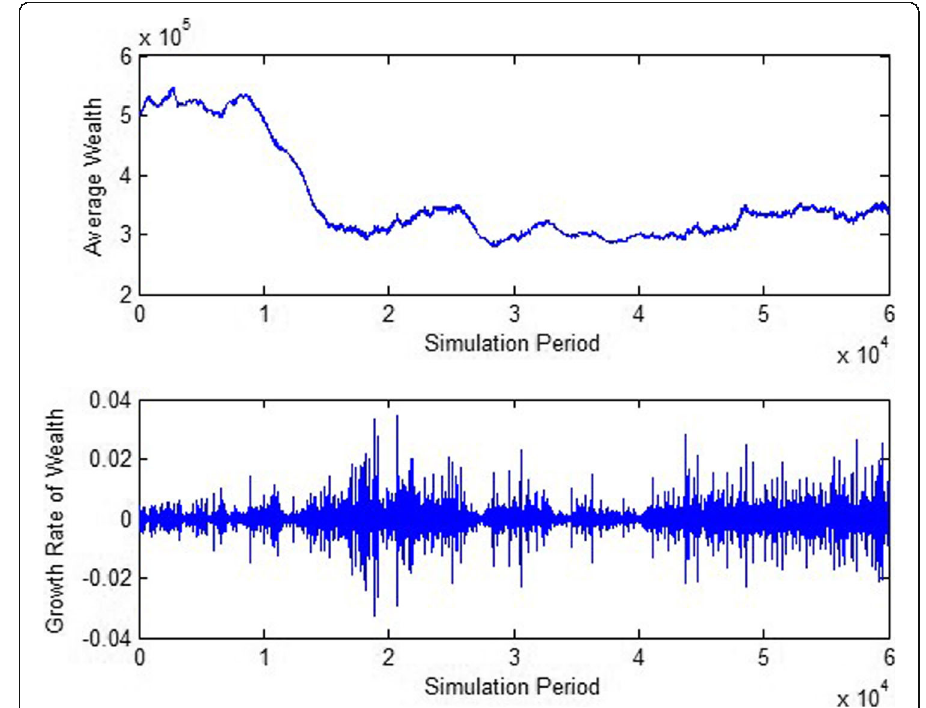
Fig. 2 Average wealth and wealth growth rate of technical traders